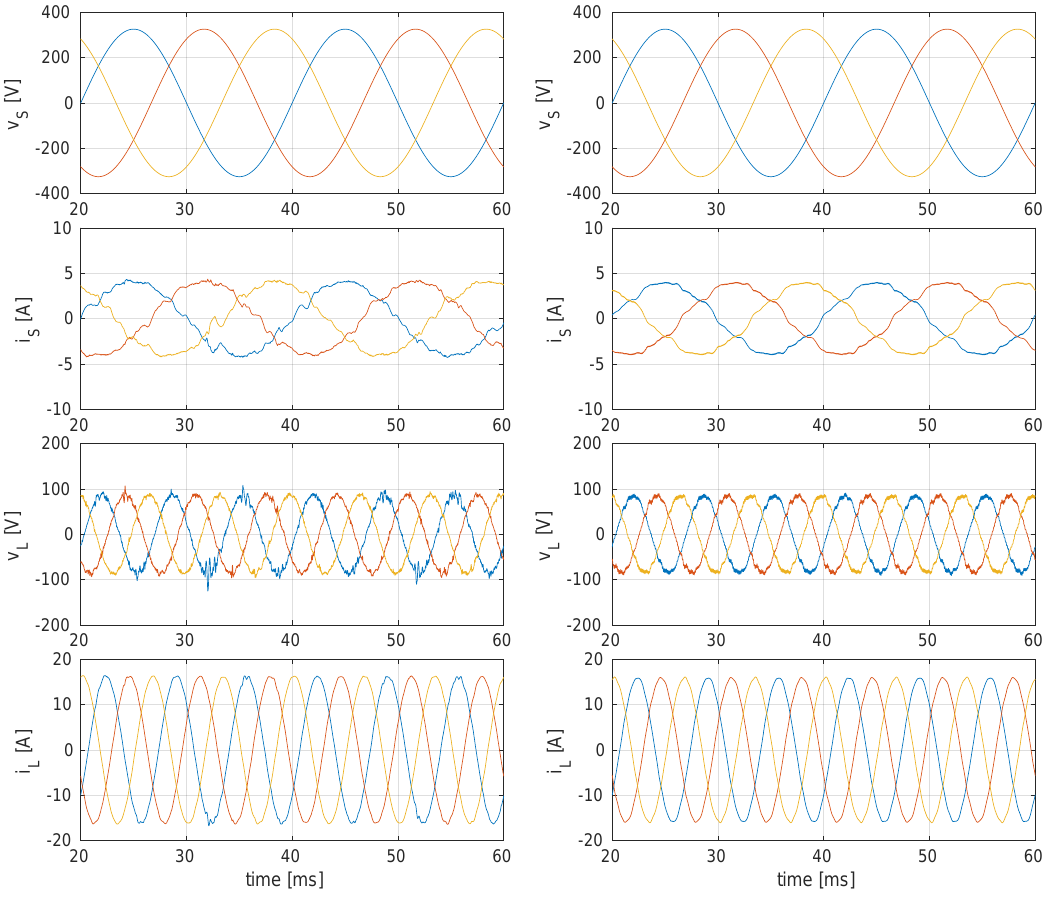
Figure 9. Simulation results of the electrical quantities at the source ( v S , i S ), and at the load ( v L , i L ). ( Left panel ) as obtained by the proposed sigma-delta modulator. ( Right panel ) as produced by a reference implementation of SVM.